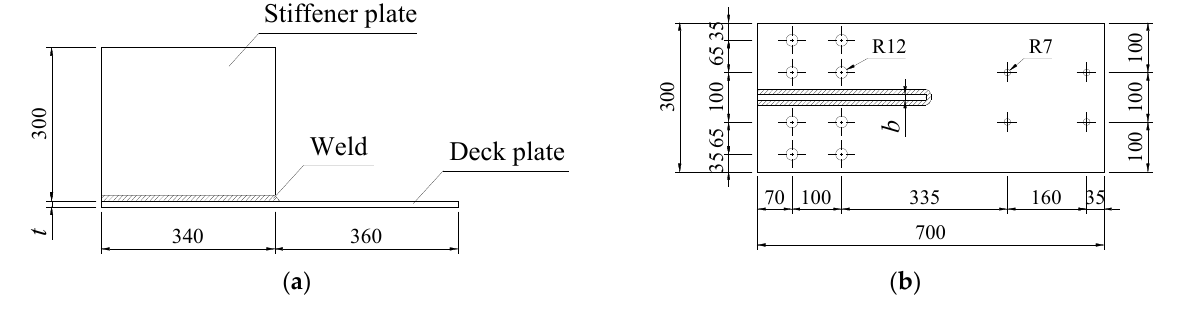
Figure 2. Configuration of test specimens (mm). ( a ) Front view. ( b ) Top view.